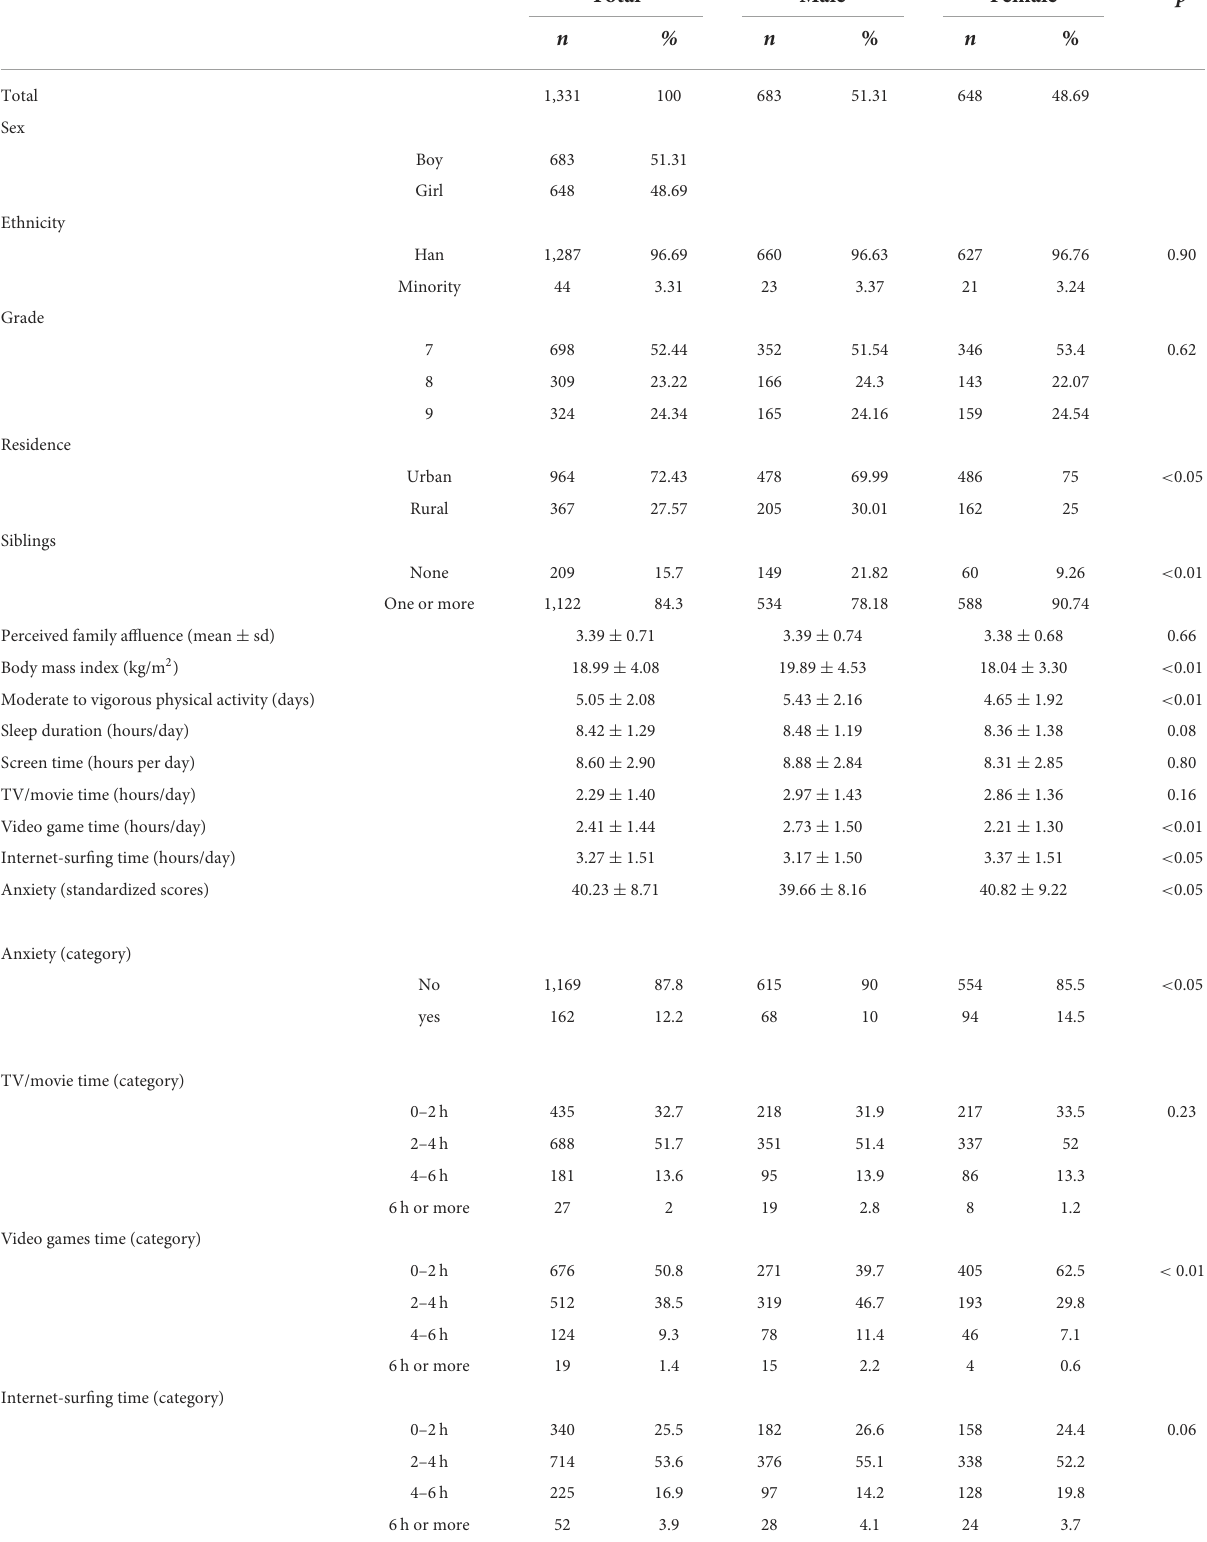
TABLE 1 Sample characteristics of this